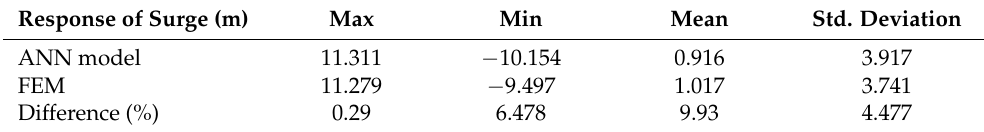
Table 3. Statistical surge response of spar platform for wave height of 12.65 m and wave period of 11.39 s. Response of Surge (m) Figure 7. Surge response time history predicted for wave height of 9.65 m and wave period of 10.10 s.